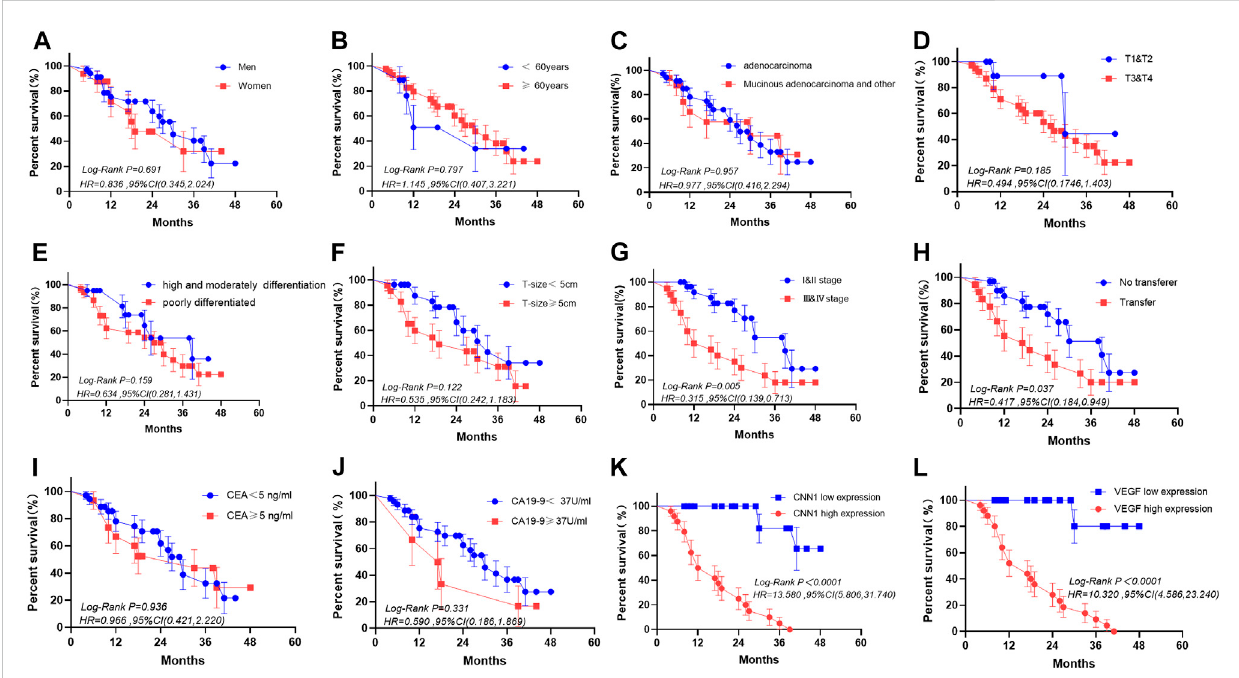
FIGURE 9 Prognosticanalysisofclinicopathologiccharacteristicsingastriccancer. (A) Sex. (B) Age(year). (C) Histologicaltype. (D) Depthoftumorinvasion. (E) Degree of differentiation. (F) Tumor size. (G) TNM staging. (H) Lymph node metastasis. (I) CEA. (J) CA 19-9. (K) Expression of CNN1. (L) Expression of